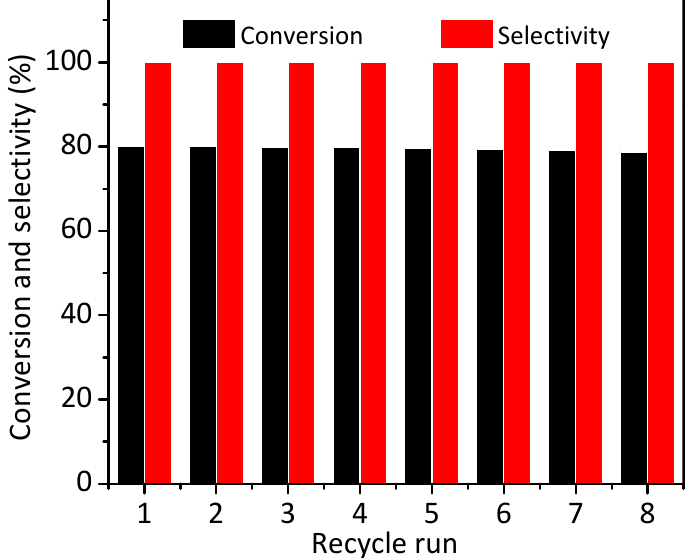
Figure 5. Reuse tests of the Pt / N-CMK-3-2 catalyst. Reaction conditions: 80 mmol nitrobenzene, 40 mg catalyst, 20 mL of ethanol, 40 °C, 2 MPa H 2 , 1.0 h.